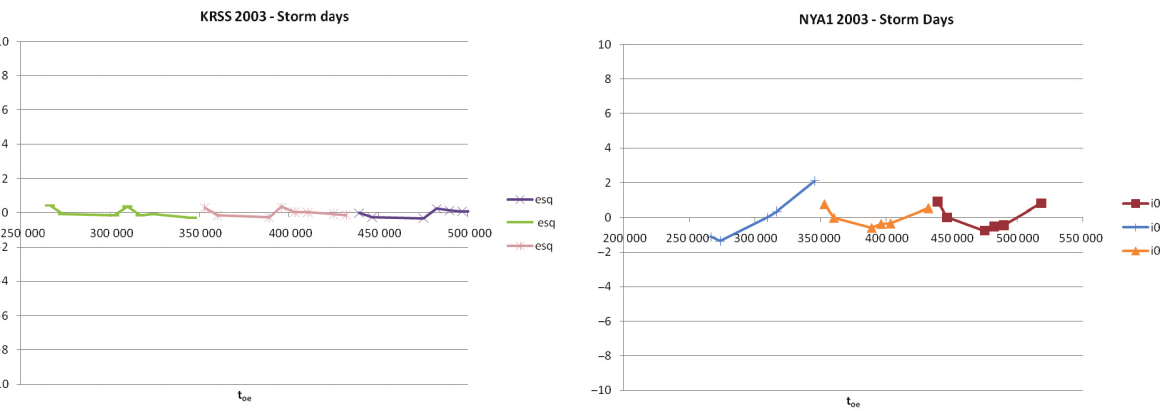
Fig. 7. Inclination for three stormy days in 2003 using cPOS stations